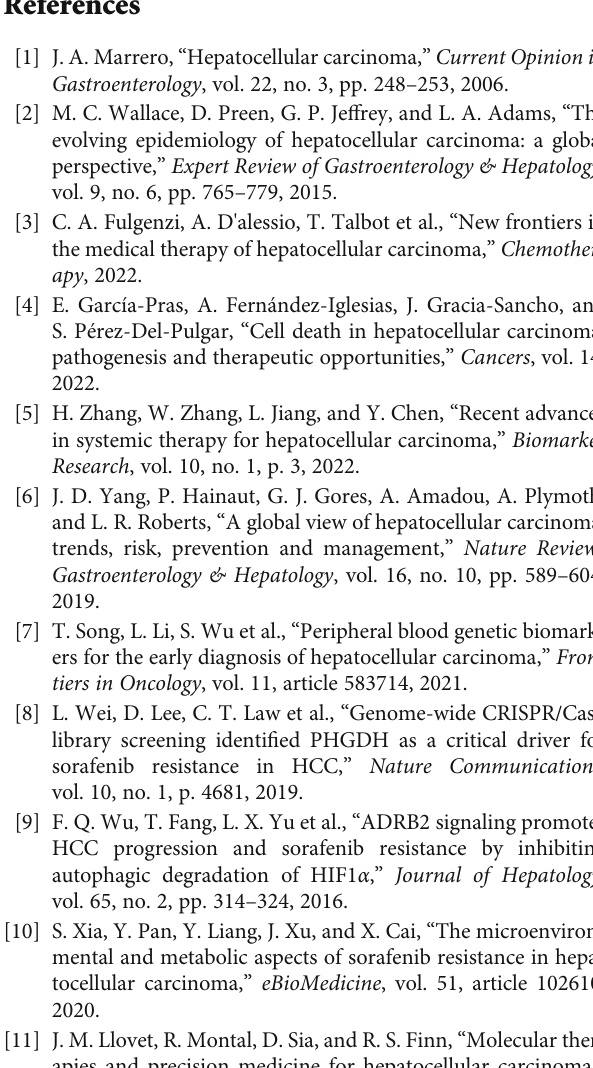
Supplementary 1 . Supplementary Table 1: siRNA sequences used in the study. Supplementary 2 . Supplementary Table 2: primer sequences for qRT-PCR